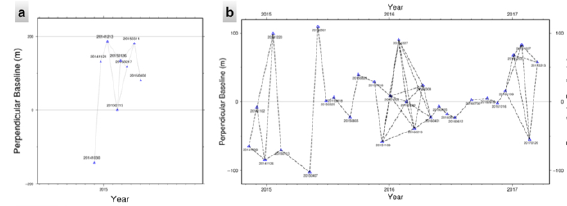
Figure 3. Spatial (vertical axis) and temporal (horizontal axis) baselines of TerraSAR-X (a) and Sentinel-1 (b) datasets during the TSInSAR-AEM